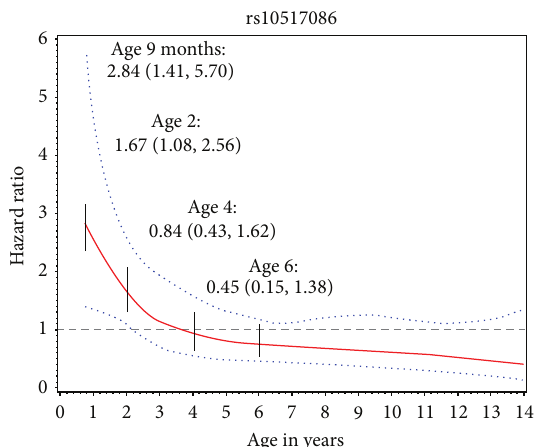
Figure 1: Association between SNP rs10517086 and development of IA modeled using a restricted cubic spline. The hazard ratio at different ages is represented by the solid line and the 95% confidence intervals are represented by the dotted lines. Hazard ratios and 95% confidence intervals are shown at 9 months, 2 years, 4 years, and 6 years (denoted with short vertical lines) illustrating the increased risk of developing IA in the younger ages, but not in older